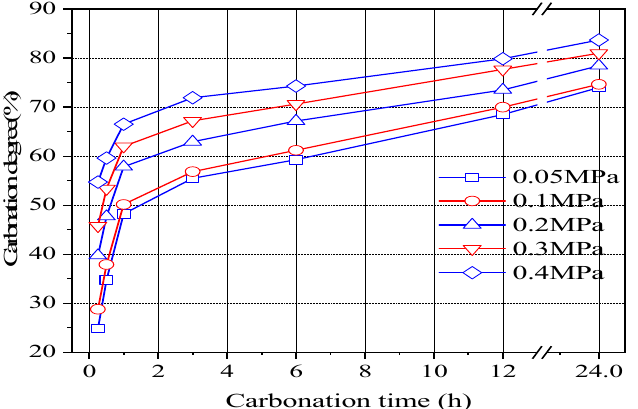
Figure 2. Carbonation degree of compacts for di ff erent CO 2 pressures vs. carbonation time